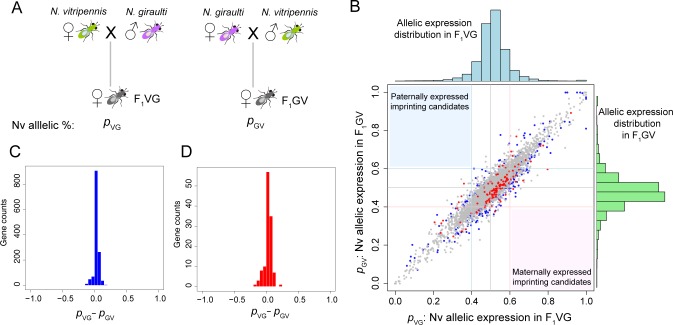
Lack of significant parent-of-origin allelic expression in reciprocal F1 crosses of Nasonia vitripennis and Nasonia giraulti.(A) Scheme of reciprocal F1 crosses between N. vitripennis (Nv) and N. giraulti (Ng). The Nv allelic expression percentage is quantified by pVG in Nv mother x Ng father cross (F1VG), and pGV in Ng mother x Nv father (F1GV). (B) Scatterplot of joint distribution of allelic expression percentage pVG (x-axis) and pGV (y-axis), for 8,623 covered genes with two or more high quality informative SNPs between Nv and Ng. Genes with significant allelic expression difference were plotted in blue (significant in all sample combined, FDR < 0.01, Fisher’s exact test) and red (significant and homogeneous in all three biological replicates; p-value < 0.01, replicated G-test of independence). Paternally expressed imprinting candidate genes should appear in the upper left corner (light-blue–shaded region), and maternal ones in the lower right corner (pink-shaded region). Histograms of pVG (blue) and pGV (green) were shown in the top and the right panel, respectively. (C) Histogram of allelic expression differences (pVG—pGV) for significant genes in all samples combined (blue dots in B). (D) Histogram of allelic expression differences (pVG—pGV) for significant genes in all biological replicates (red dots in B). Data presented in this figure can be found at http://dx.doi.org/10.5061/dryad.qf2t8.